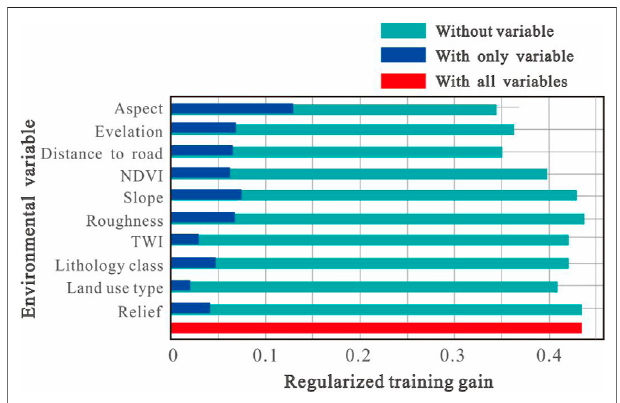
FIGURE 7 | Contribution of different indexes to landslide susceptibility